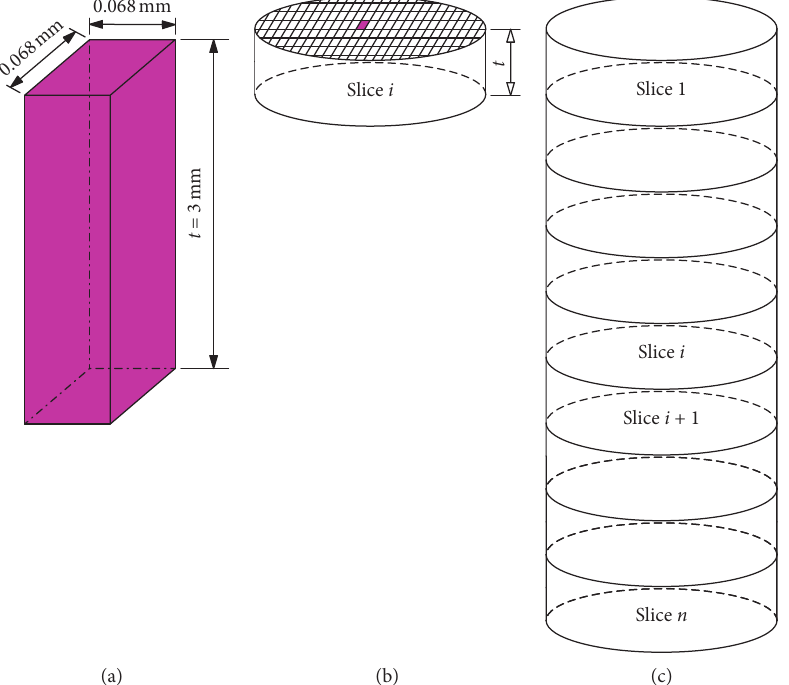
Figure 6: Schematic diagram of three-dimensional vectorization of microscopic images of rock samples. (a) The voxel unit. (b) The aggregate of single-layer voxel unit. (c) The whole rock